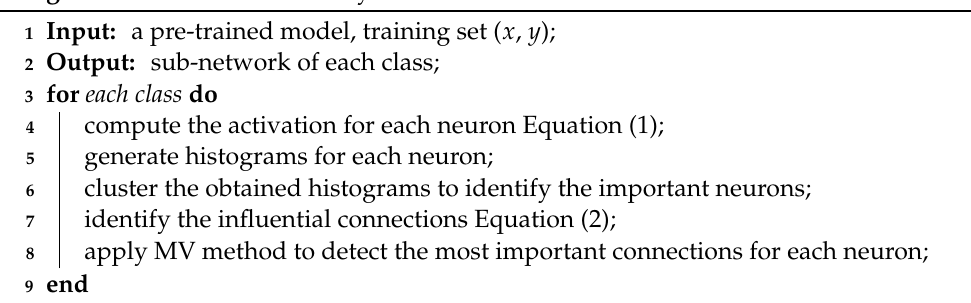
Algorithm 1: Network Pathway Extraction.